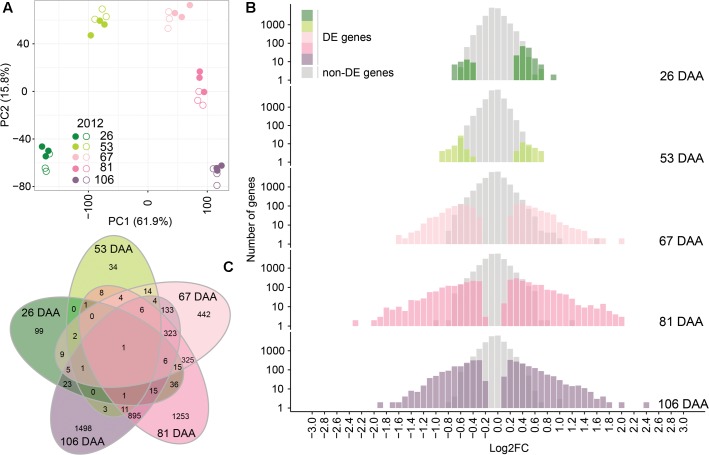
Analysis of CT and WD berry transcriptome in 2012. (A) PCA of the transcriptome of the 30 independent samples analyzed. Full and open symbols identify CT and WD berries, respectively. Colors from dark green to light pink to violet indicate the developmental stage (DAA) as reported in the figure legend. (B) Number of differently expressed (DE) genes and their log2FC (WD/CT) at 26, 53, 67, 81, and 106 DAA. (C) Commonly and uniquely DE genes at 26, 53, 67, 81, and 106 DAA represented in a Venn diagram.